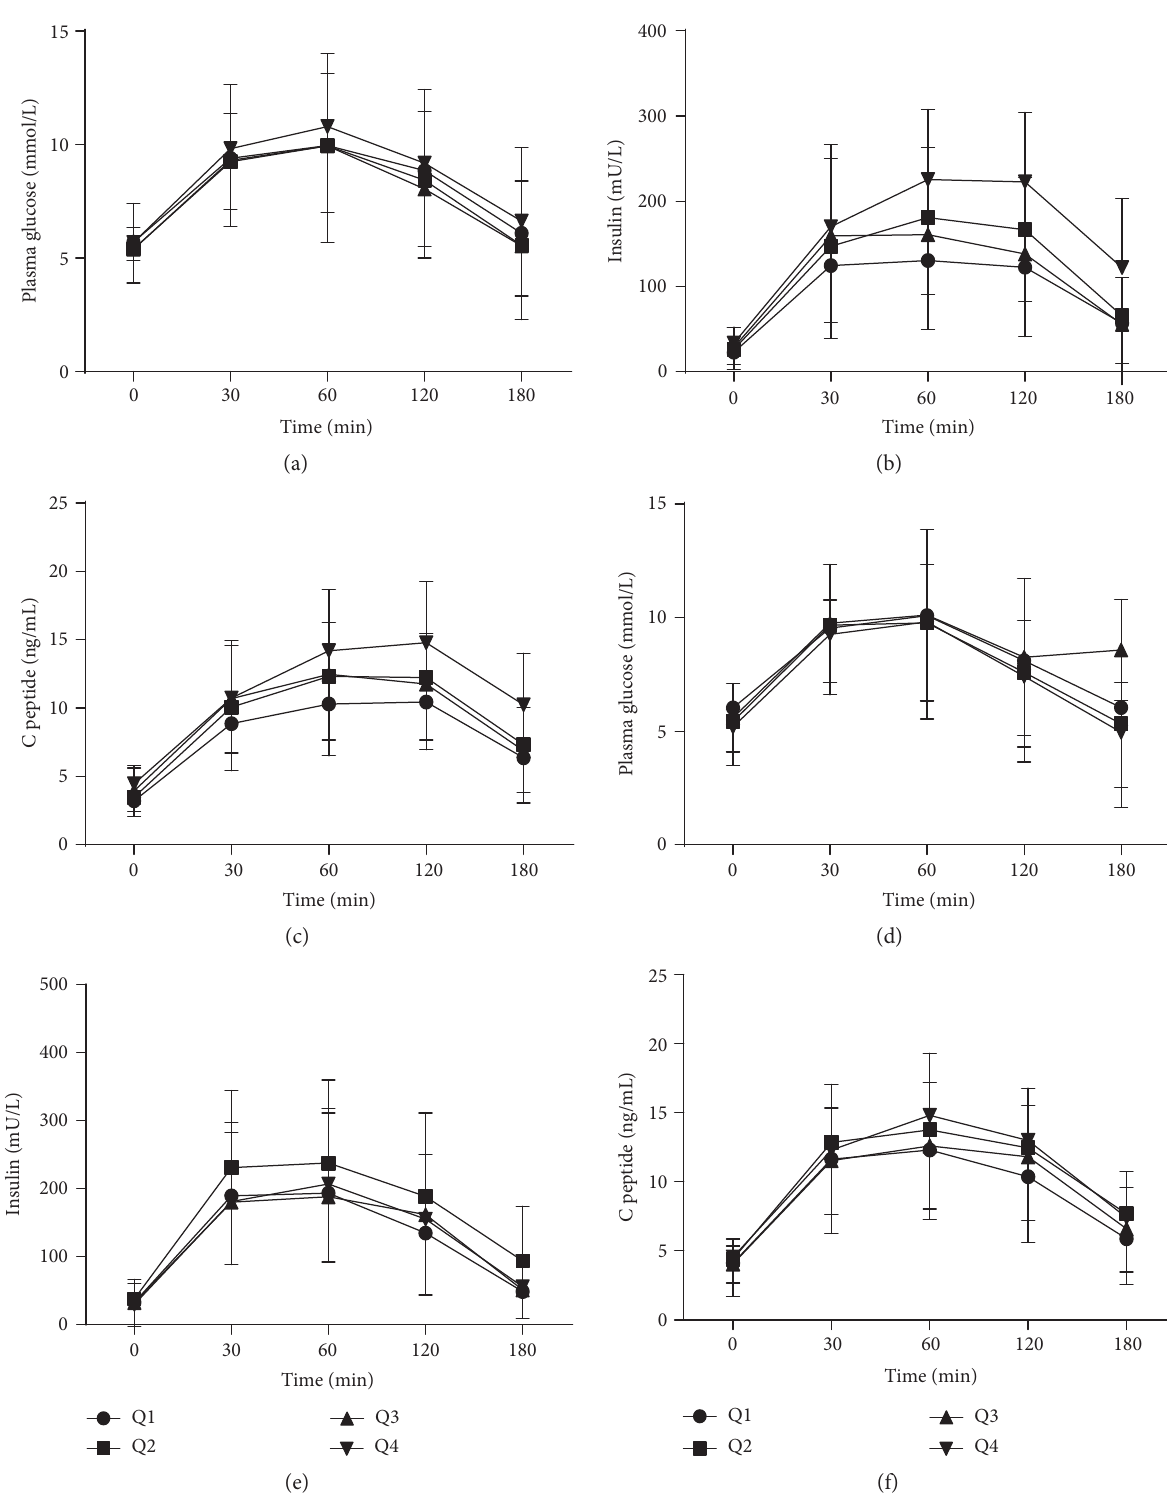
Figure 1: The change of glucose, insulin, and C peptide levels according to serum UA quartiles in females and males. (a) For females, no signi fi cant di ff erence was observed in glucose level across quartiles at any point ( P = 0 320 ). (b) For females, signi fi cant di ff erence was observed in insulin levels across the serum UA quartiles ( P < 0 001 ). (c) For females, signi fi cant di ff erence was observed in C peptide levels across the serum UA quartiles ( P < 0 001 ). (d) For males, no signi fi cant di ff erence was observed in glucose level across quartiles at any point ( P = 0 496 ). (e) For males, no signi fi cant di ff erence was observed in insulin levels across quartiles at any point ( P = 0 108 ). (f) For males, signi fi cant di ff erence was observed in C peptide levels across the serum UA quartiles ( P = 0 042